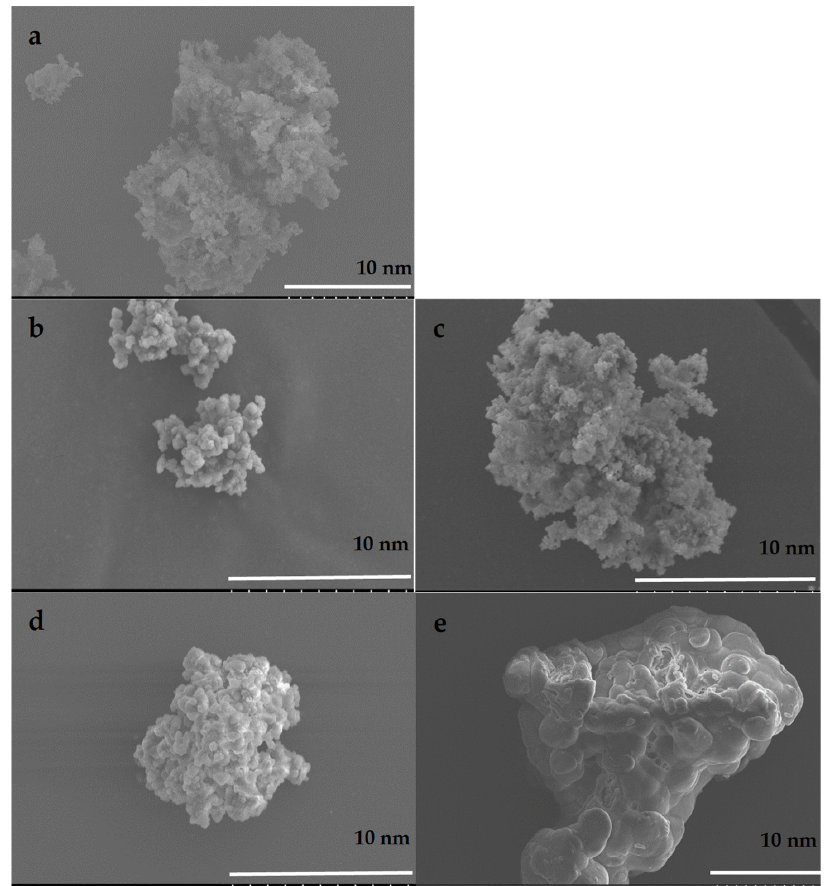
Figure 1. SEM images for ( a ) g-C 3 N 4 , ( b ) arsenate-imprinted polymer, ( c ) arsenate-imprinted polymer with g-C 3 N 4 , ( d ) ammonia-imprinted polymer, ( e ) ammonia-imprinted polymer with g-C 3 N 4 .